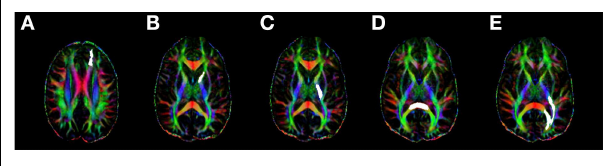
FIGURE 2 | A representative sample of the regions of interest (highlighted in white) measured for each subject using ROQS: (A) anterior corona radiata; (B) anterior limb of the internal capsule; (C) posterior limb of the internal capsule; (D) splenium of the corpus callosum; (E) optic